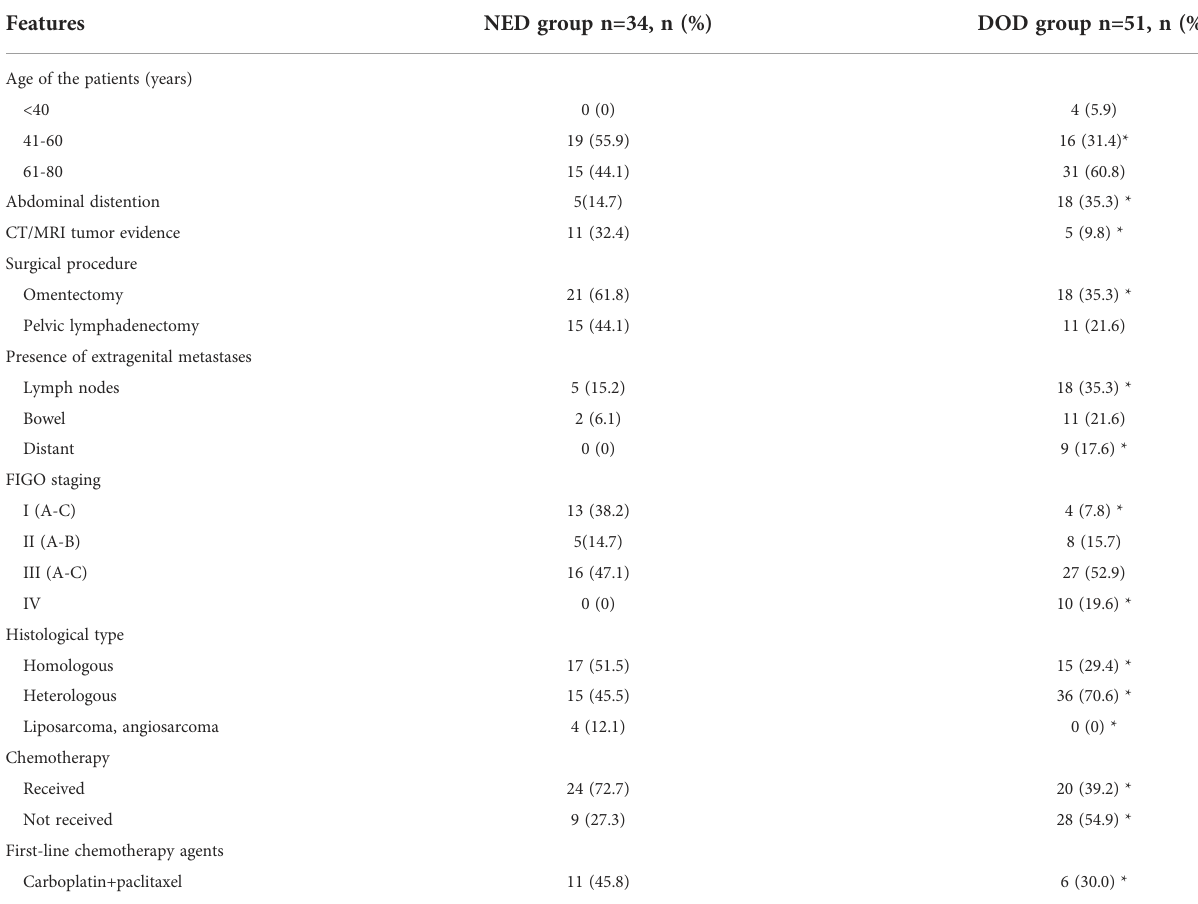
TABLE 2 The features of 85 cases of fallopian MMMT and